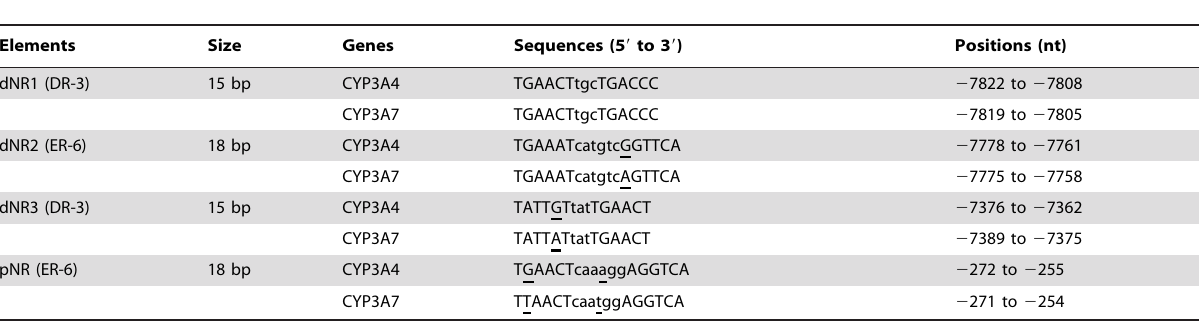
Table 2. Promoter elements maintained in the CYP3A4G/7R BAC